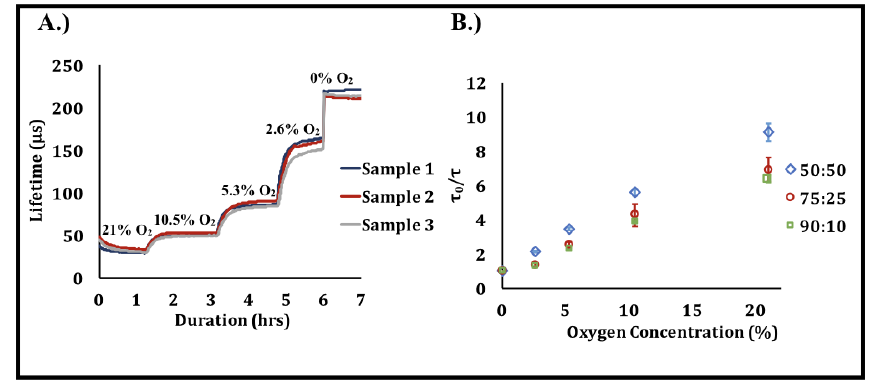
Figure 4. Effect of oxygen concentration on phosphorescence lifetime. ( A ) Raw data illustrating the changes in phosphorescence lifetime over time as oxygen concentration is reduced [n = 3 samples, 50:50 poly(2-hydroxyethyl methacrylate (HEMA)-co-acrylamide (AAm))]. These data are representative of a typical oxygen response profile obtained from a single oxygen response test. ( B ) Oxygen response of the three hydrogel urate biosensor compositions. Each data point represents a steady-state average of n = 3 samples of the sample composition. Error bars represent 95% confidence intervals.